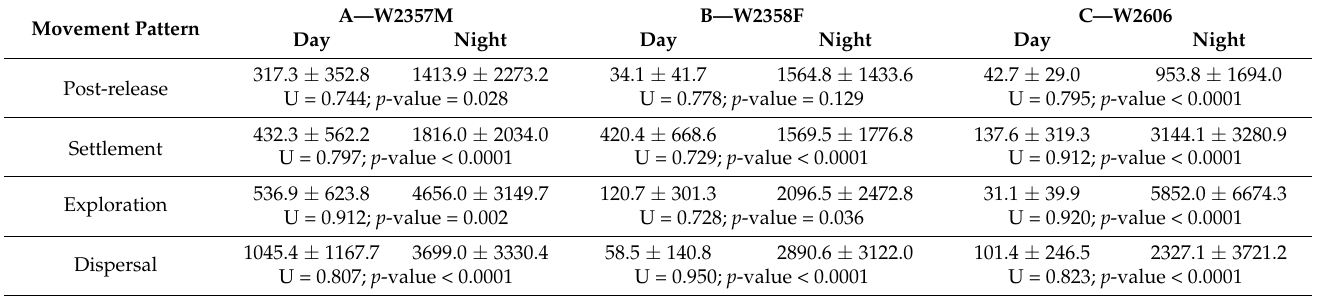
Table 2. Differences in diurnal and nocturnal step lengths (m) (mean ± SD) within each movement pattern of three GPS-collared wolves in Northern Italy, 2019–2021. U = Mann–Whitney